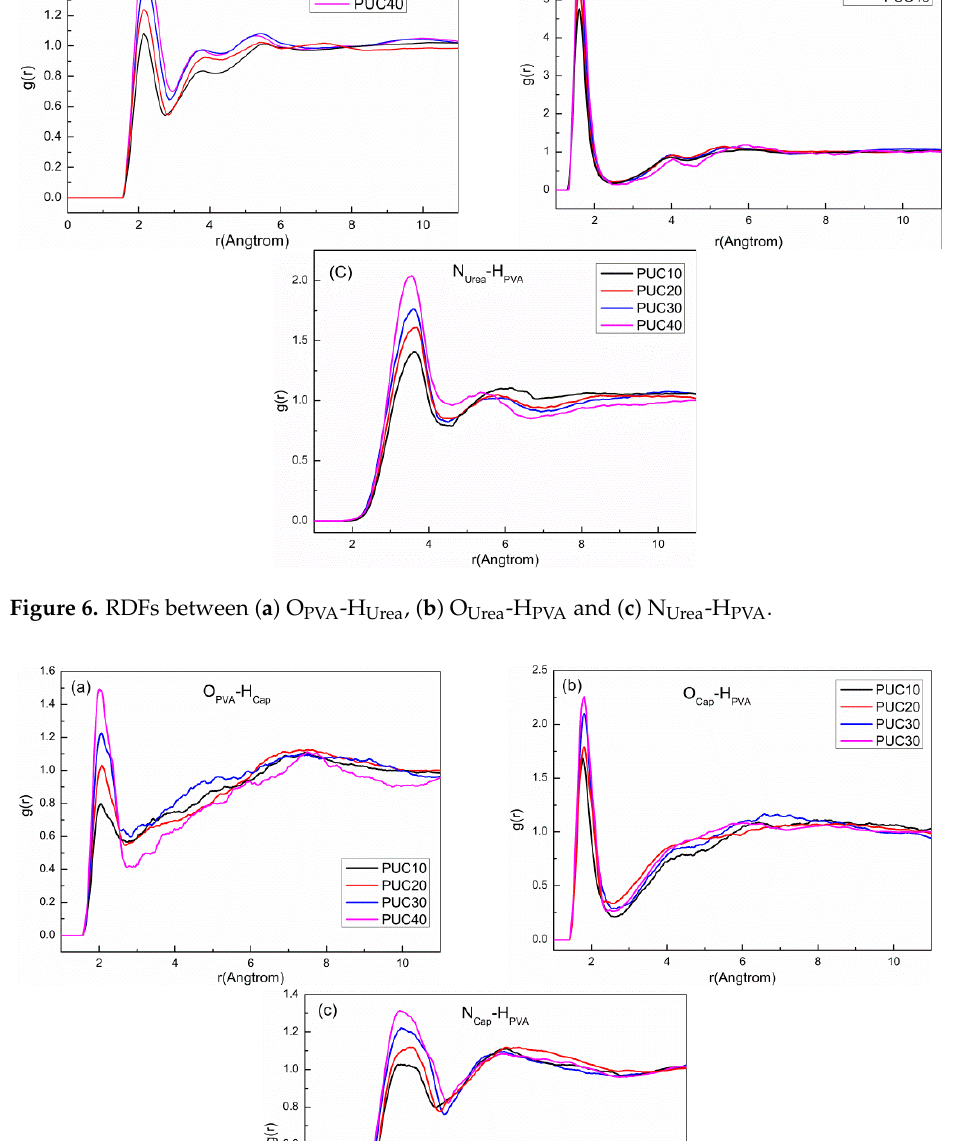
Figure 7. The RDFs between ( a ) O PVA -H Cap , ( b ) O Cap -H PVA and ( c ) N Cap -H PVA . In general, hydrogen bonding is the main interaction between the polar functional groups of UC and PVA. With the increase in the UC content, the interaction between PVA and water decreased, and there were more hydrogen bonds formed between PVA and UC, which destroyed the intramolecular and intermolecular hydrogen bonds of PVA, granting PVA a looser structure. This conclusion could be verified through the fractional free volume (FFV) of PVA composites. As shown in Figure 8, the FFV of PVA composites increased with the increase in plasticizer content, indicating that the intermolecular force of PVA decreased with the increase in UC content. This conclusion could also be veri fi ed through the swelling of PVA composites, as shown in Table 2. With the increase in UC content, the fi nal converged density of the equilibrium conformations decreased, and the cell length and volume increased. The above e ff ect increased the di ff usion coe ffi cient of water molecules in PVA composites with increasing UC content. Figure 8. Simulated free volume morphologies of ( a ) PUC0, ( b ) PUC10, ( c ) PUC20, ( d ) PUC30 and ( e ) PUC40. Grey areas represent the free volume.